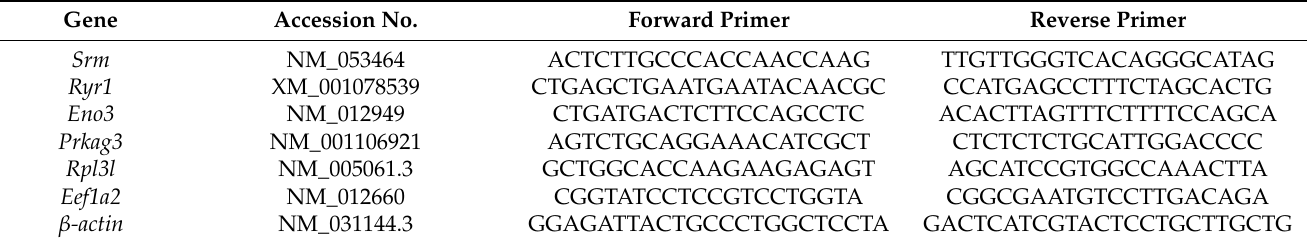
Table 2. Primers used for qRT-PCR to determine gene expression in gastric